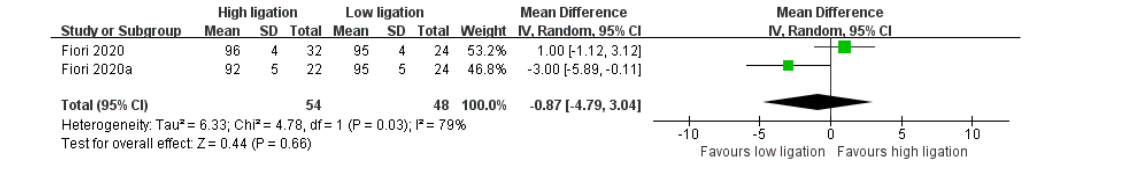
Figure 4. Forest plot of defecatory dysfunction assessed by the overall score of the fecal incontinence quality of life scale (long-term) .